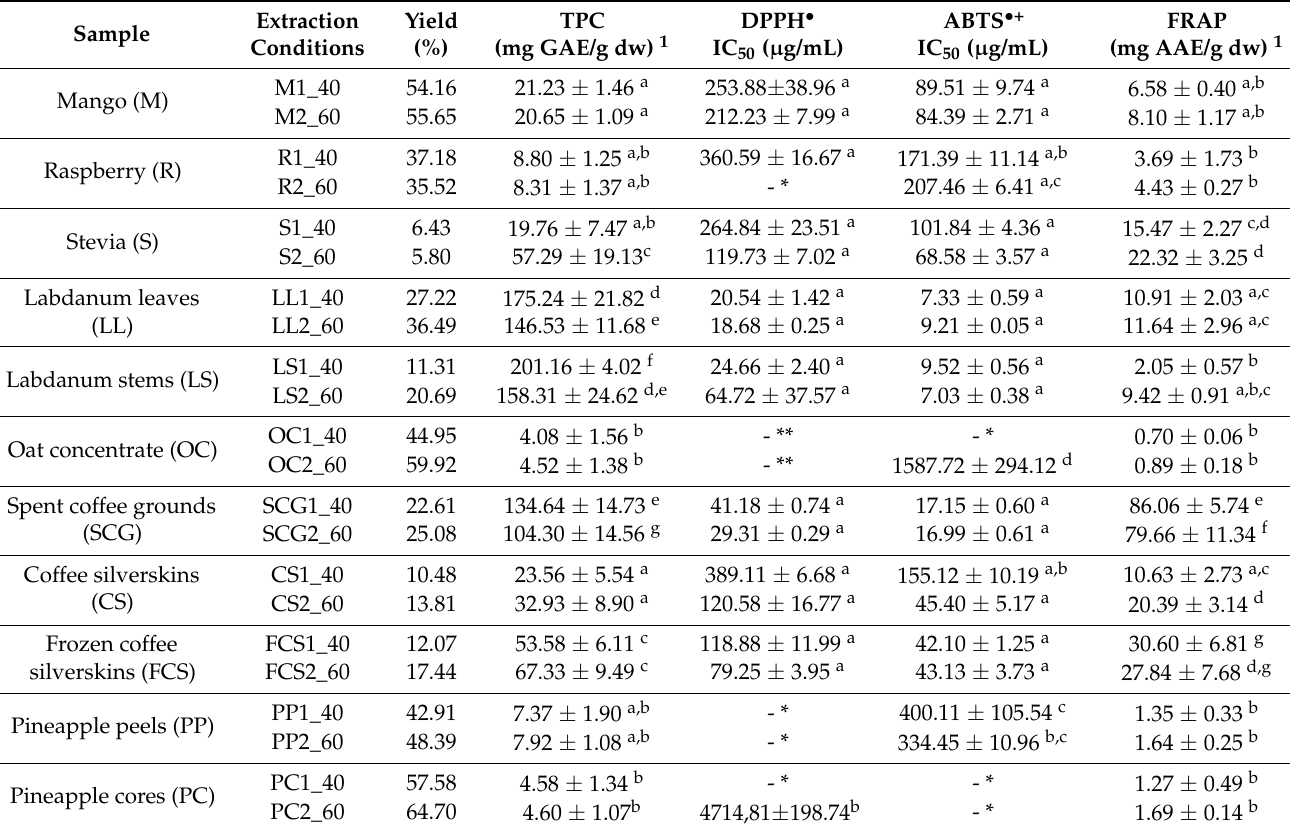
Table 2. Yield, TPC, and AA of the tested